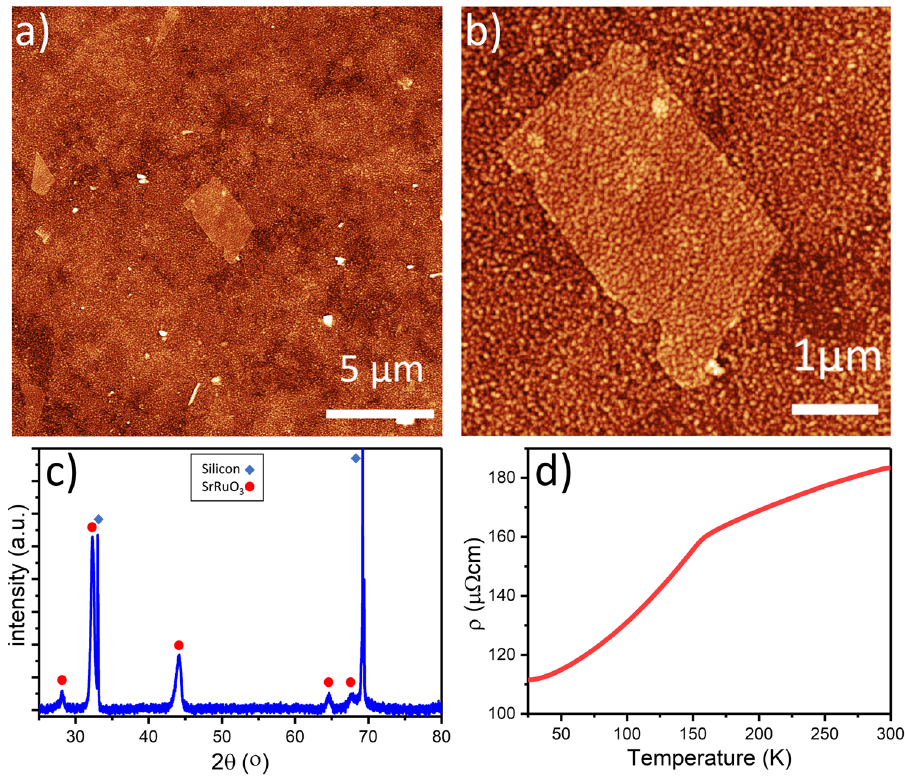
Figure 3. ( a , b ) AFM images of SrRuO 3 film deposited on nanosheets at two different magnifications. ( c ) X-ray diffractograms of the deposited SrRuO 3 film. The characteristic peaks of SrRuO 3 and Si are indicated with red and blue dots, respectively. ( d ) Resistivity of the SrRuO 3 film versus